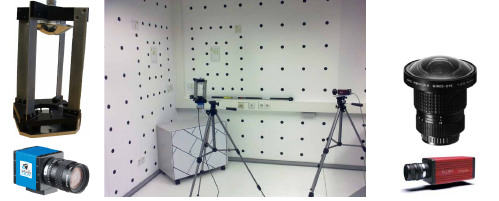
Figure 8: Experimental design of heterogeneous stereo system 1